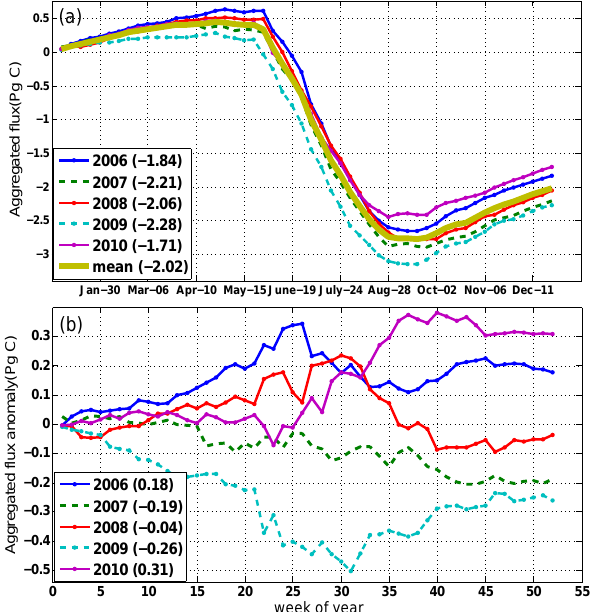
Figure 7. (a) Cumulative net Asian ecosystem exchange (NEE) vs. time estimated in our system for each of the individual years and for the 2006–2010 mean. This figure reveals the largest uptake in 2009 and the smallest uptake in 2010. (b) Cumulative anomaly of Asian CO 2 exchange through the years 2006 to 2010. The inferred Asian carbon fluxes shown here include only respiration and photosyn- thesis, because the biomass-burning emissions have a large inter- annual variability.